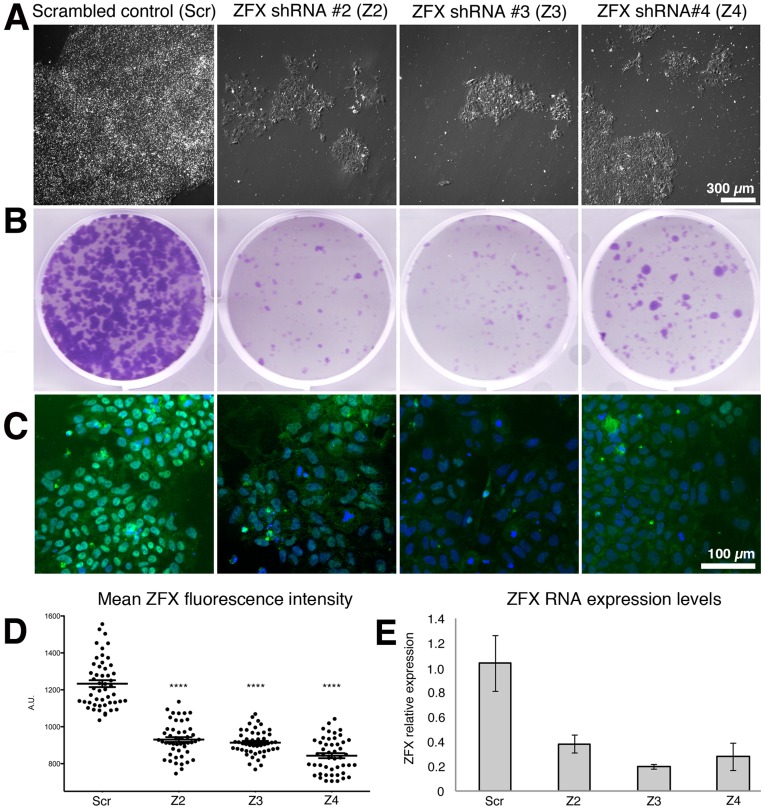
ZFX knockdown impairs hESC colony size.Human ESCs were transduced with ZFX knockdown lentiviral constructs and a scrambled control before clonal replating. (A) Live cell images and (B) and the entire well stained with crystal violet seven days after replating. (C) ZFX immunofluorescence after knockdown in hESCs, and (D) ZFX quantitative immunofluorescence analysis. Each dot is the average pixel intensity of nuclear ZFX protein averaged from all cells in one microscopic field. The average pixel intensity from 50 microscopic fields derived from 3 independent experiments is shown. The crosshairs and whiskers represent the mean and SEM. All knockdowns were significantly different from the scrambled control (p<0.0001 for t-tests of each knockdown versus scrambled). 11,803 (Scr), 10,296 (Z2), 4,765 (Z3) and 6,905 (Z4) nuclei were measured in these experiments. (E) ZFX RNA levels as measured by quantitative PCR after knockdown.